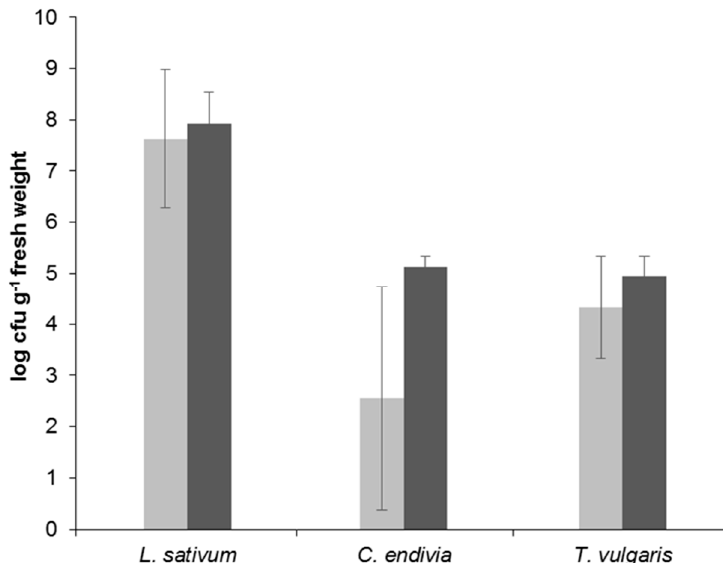
Figure 2. Viable counts (log 10 CFU g − 1 fresh weight) of cultivable bacteria obtained from three plant species. Shown are mean values of five plants for the first (light gray bars) and second (dark gray bars) experiment, with the standard deviation as error bars.